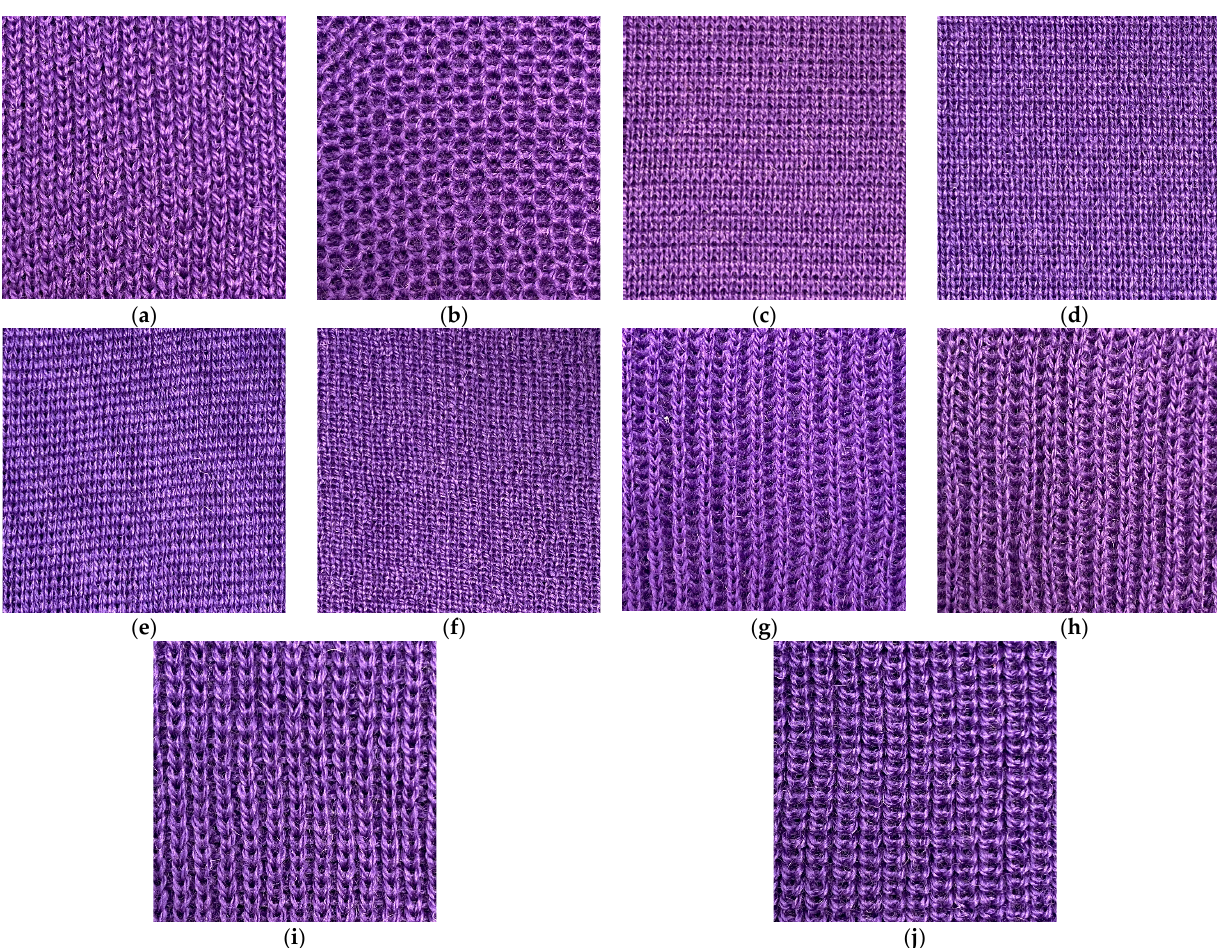
Figure 3. Images of the investigated knitted structures: ( a ) single tuck stitch, technical face side; ( b ) single tuck stitch, technical back side; ( c ) Milano rib 1 × 1, technical face side; ( d ) Milano rib 1 × 1, technical back side; ( e ) half-Milano rib 1 × 1, technical face side; ( f ) half-Milano rib 1 × 1, technical back side; ( g ) cardigan rib 1 × 1, technical face side; ( h ) cardigan rib 1 × 1, technical back side; ( i ) half-cardigan rib 1 × 1, technical face side; ( j ) half-cardigan rib 1 × 1, technical back side.